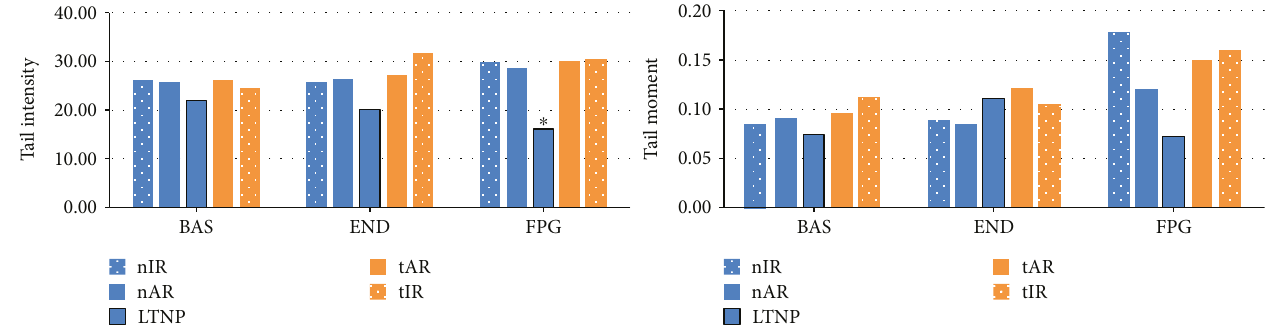
Figure 6: Leukocyte DNA damage of the 92 people living with HIV/AIDS, according to the fi ve study groups, in three conditions — basal (BAS), that is, blades without enzymes treatment, or blades with enzymatic treatment (endonuclease III enzyme [END] and formanodipirimidina-DNA glycosylase, [FPG]). The LTNP group presented the lowest DNA damage; Statistical tests: gamma distribution for BAS-tm, END-tm and FPG-tm, and ANOVA for the others. ∗ p < 0 05 , di ff erence among all the other groups.